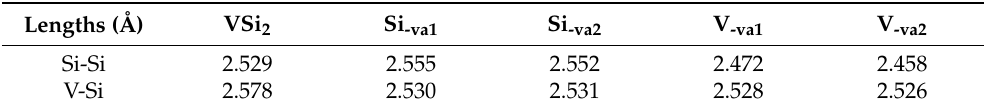
Table 7. The bond lengths of Si-Si covalent bonds and V-Si bonds for perfect C11 b -VSi 2 and C11 b -VSi 2 with different atomic